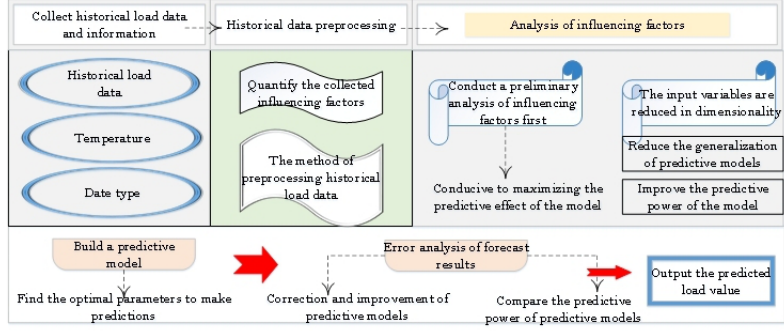
Fig. 2. Short-term power load forecasting process